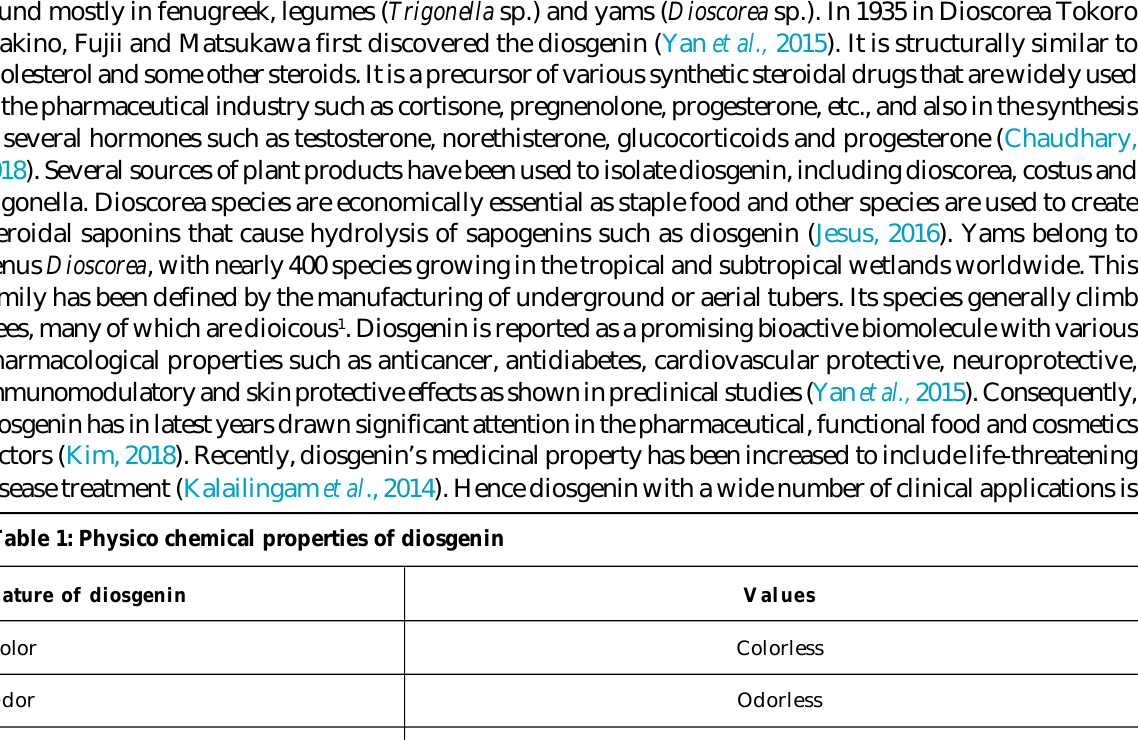
Figure 1: Structure of diosgenin